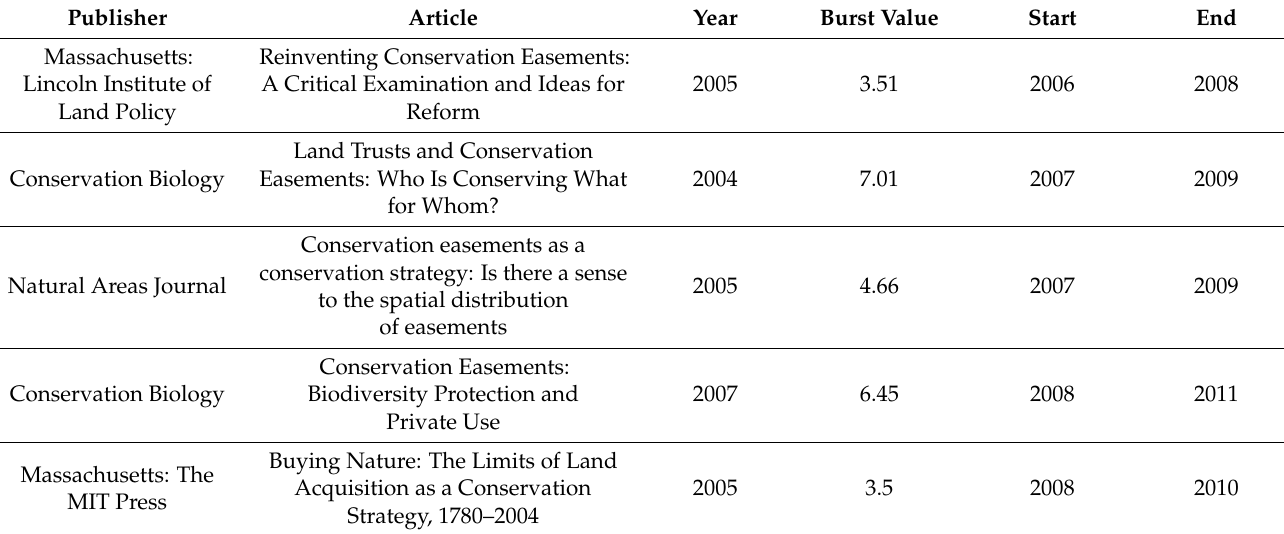
Table 3. Land trust documents with the strongest citation